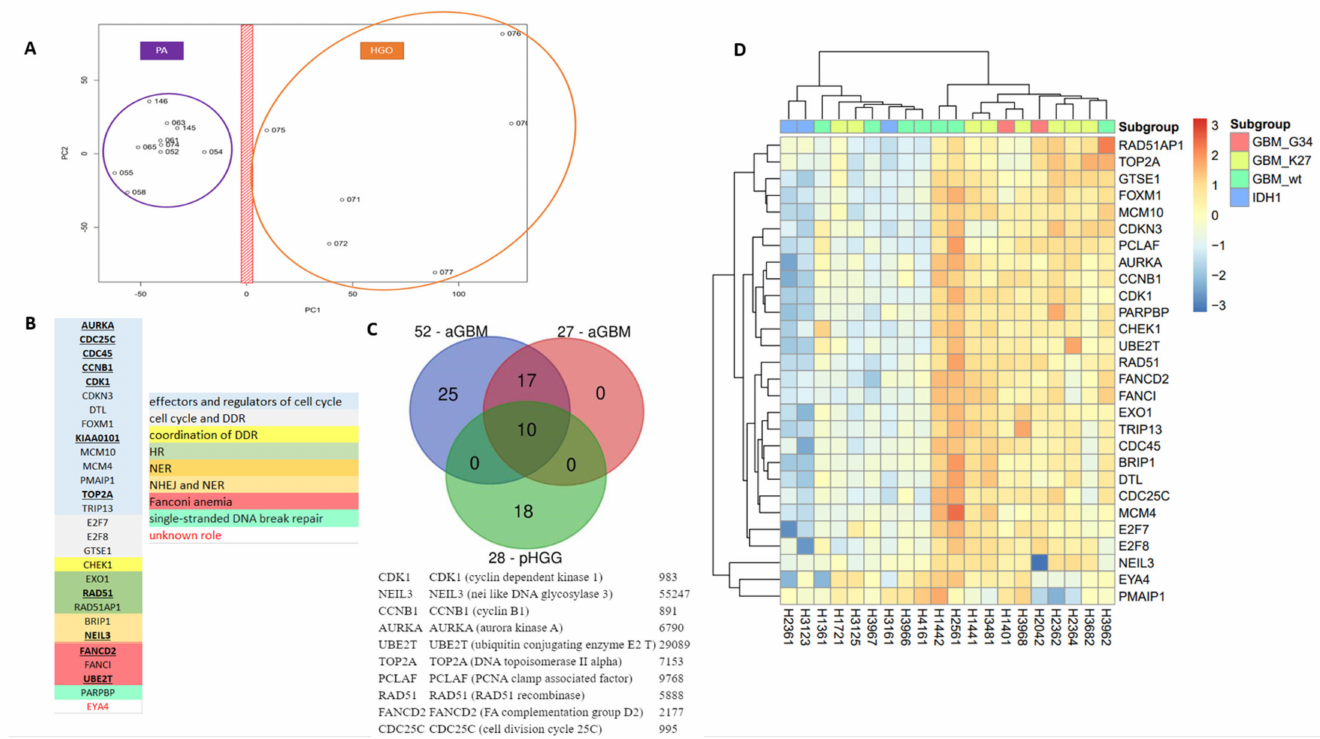
Figure 3. A specific 28-gene DNA repair and cell cycle gene expression signature distinguishes pHGGs from pediatric low- grade gliomas. ( A ) Principal component analysis score plot for pilocytic astrocytoma (PA) samples and pHGG specimens. ( B ) Identity and features of the 28 DNA repair and cell cycle genes composing the signature of pHGGs. Underlined genes are also present in the aGBM signatures of Gobin et al. ( C ) Venn diagram showing how the 28-gene pHGG signature overlaps with the 52- and 27-gene aGBM signatures, and list of the 10 genes shared by these signatures. ( D ) Heatmap illustrating the segregation of sus-tentorial pHGG specimens into 2 groups based on the pediatric DDR gene